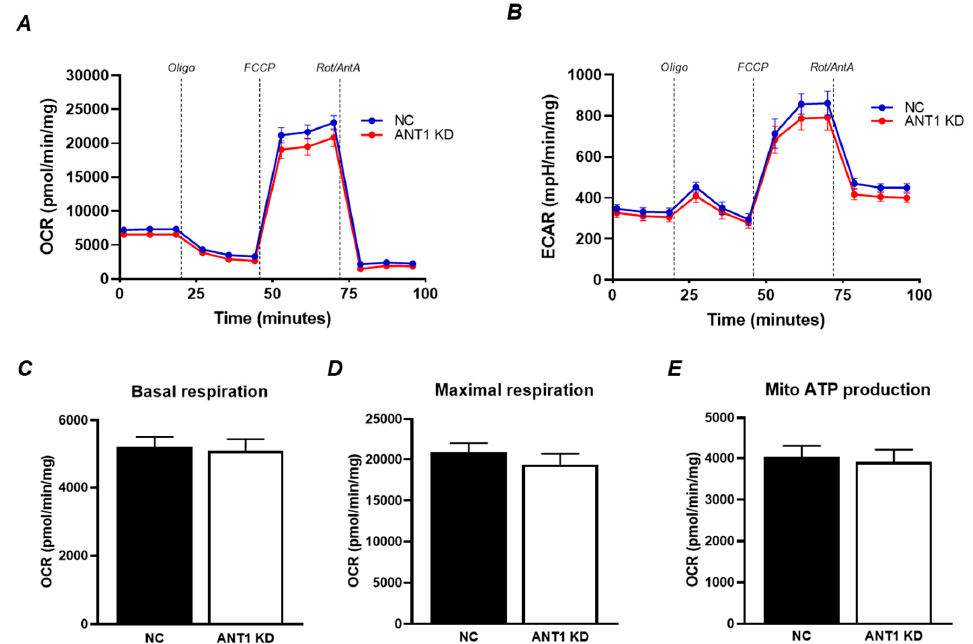
Figure 3. Mitochondrial oxygen consumption and ATP production is not affected by ANT1 downregulation. ( A ) oxygen consumption rate (OCR); ( B ) extracellular acidification rate (ECAR); ( C ) basal respiration; ( D ) maximal respiration; ( E ) mitochondrial ATP production. All parameters were determined using the Seahorse XFe24 analyzer (Agilent) after the addition of (in µ M): 0.5 oligomycin (Oligo), 4 FCCP, and 0.5 rotenone / antimycin A (Rot / AntA). The data was extracted using the Seahorse XFe24reportgeneratorandnormalizedtototalproteinlevels.